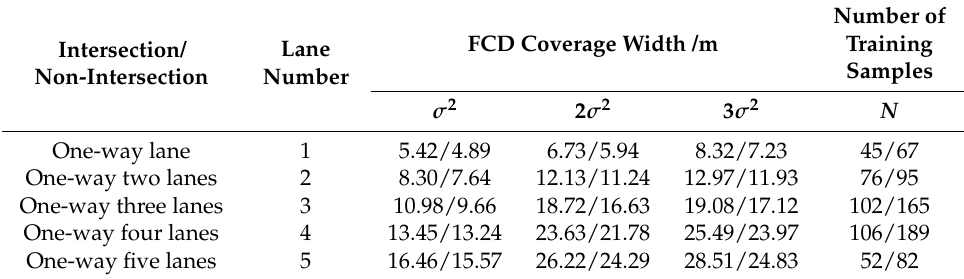
Table 3. Results of the basic classifier based on lane number detection in the FCD experimental area.